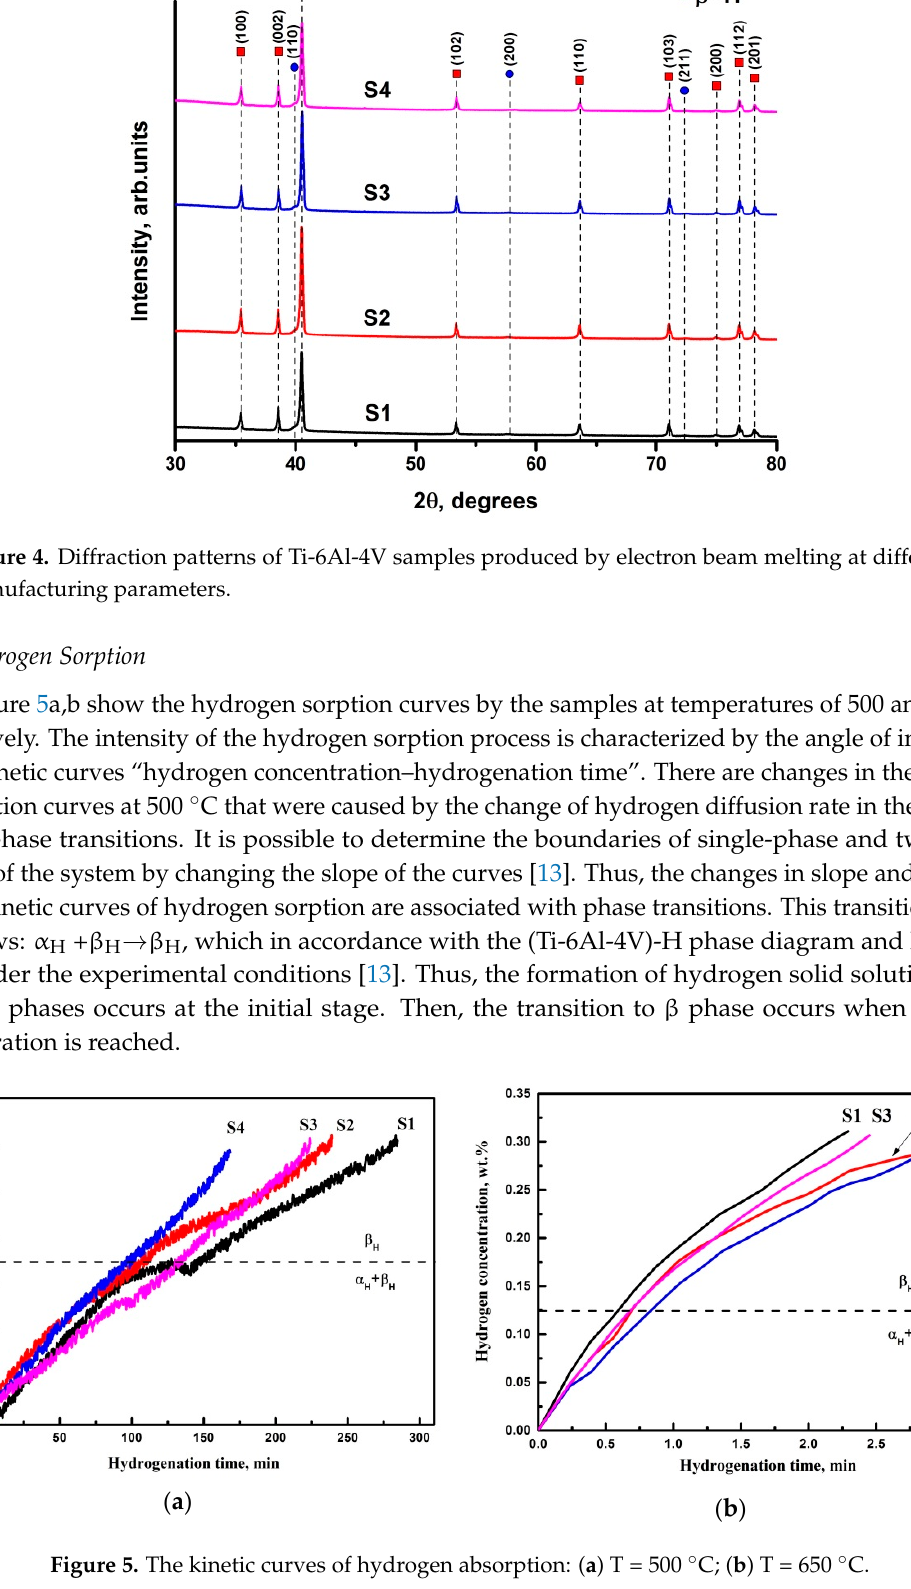
( d ) Figure 3. SEM images of the samples ( a , b ) and histogram ( c , d ) of the thickness distribution of α plates, respectively: ( a , c )—S3, ( b , d )—S4. Figure 4 shows the results of X-ray diffraction analysis of electron beam melted Ti-6Al-4V parts at different manufacturing parameters (see Table 1). The phase content and lattice parameters are presented in Table 2. According to XRD analysis, the α -Ti ( α′ -Ti) phase with hexagonal close-packed (hcp) lattice and β -Ti phase with body-centered cubic (bcc) lattice were observed in all the samples. It is impossible to perceive the differences between α -Ti and α′ -Ti in the EBM samples using XRD [35,36]. The change in electron beam melting parameters does not significantly affect the structure and phase composition of the additively manufactured Ti-6Al-4V samples. The content of β phase in the samples varies from 2.4 to 3.1 vol %. The accuracy of XRD analysis does not allow revealing of the peculiarities of the EBM parameters’ effect on the formed β titanium phase content. It is assumed